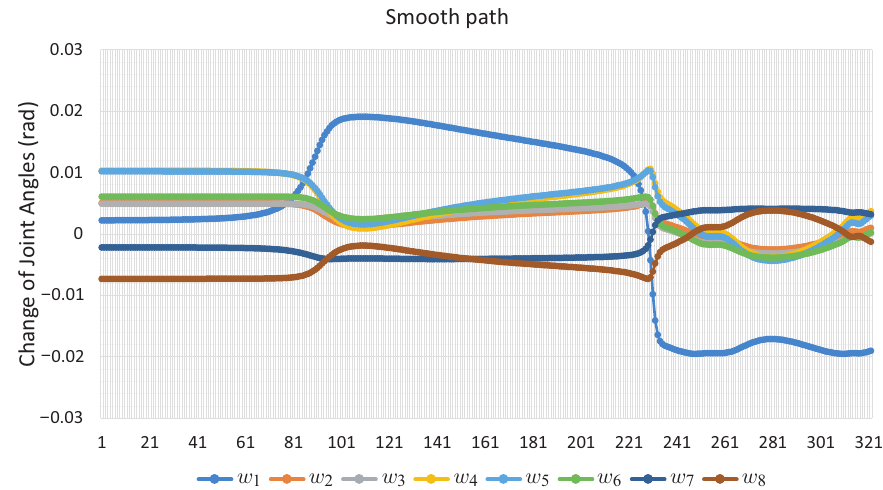
Figure 17. Change of joint angle motion of Case Study 2.